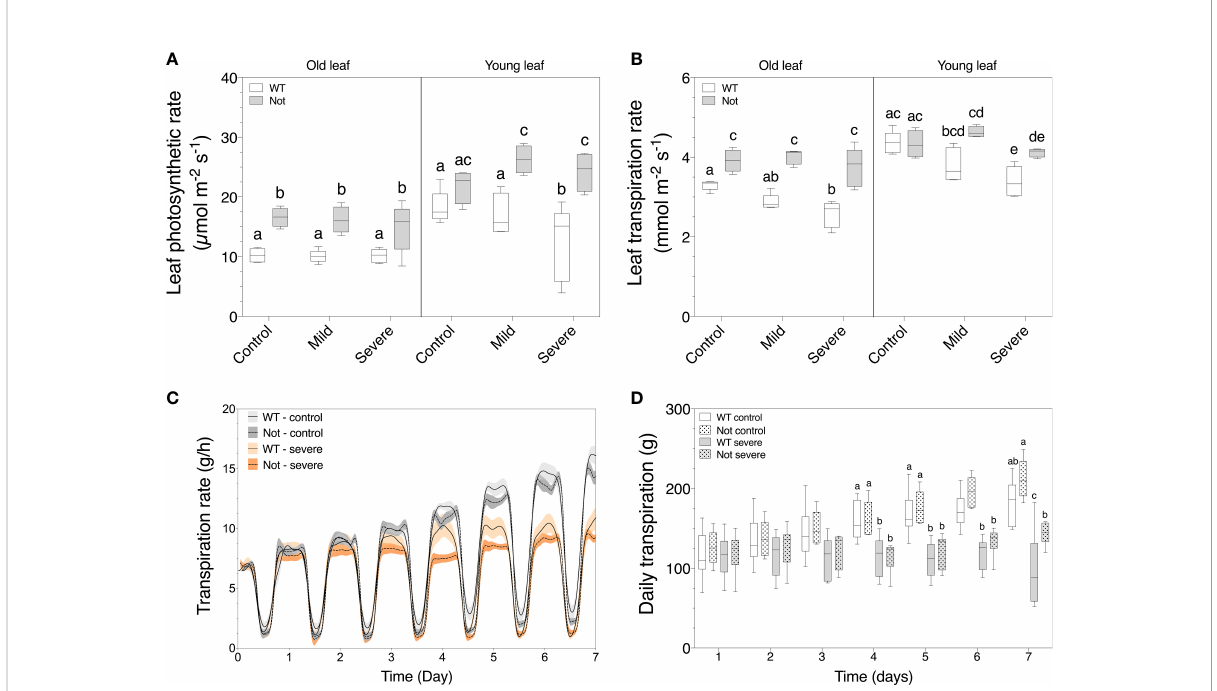
FIGURE 4 Plant transpiration and leaf photosynthetic and transpiration rate of old (leaf no. 3) and young (leaf no. 8) leaves in wild-type (white) and notabilis (gray) after 7 days under control (EC of 2.5 dS/m), mild (EC of 5 dS/m; [NaCl] = 47 mM) and severe (1EC of 10 dS/m; [NaCl] = 94 mM) salt stress conditions. (A) Leaf photosynthetic rate (n = 10), (B) leaf transpiration rate (n = 10), (C) real-time plant transpiration rate (n = 10) and (D) daily transpiration rate (n = 10) during 7 days of salt stress. Signi fi cant differences are indicated with different letters ( a = 0.05). Lines in (C) represent average leaf angles +/- the con fi dence interval